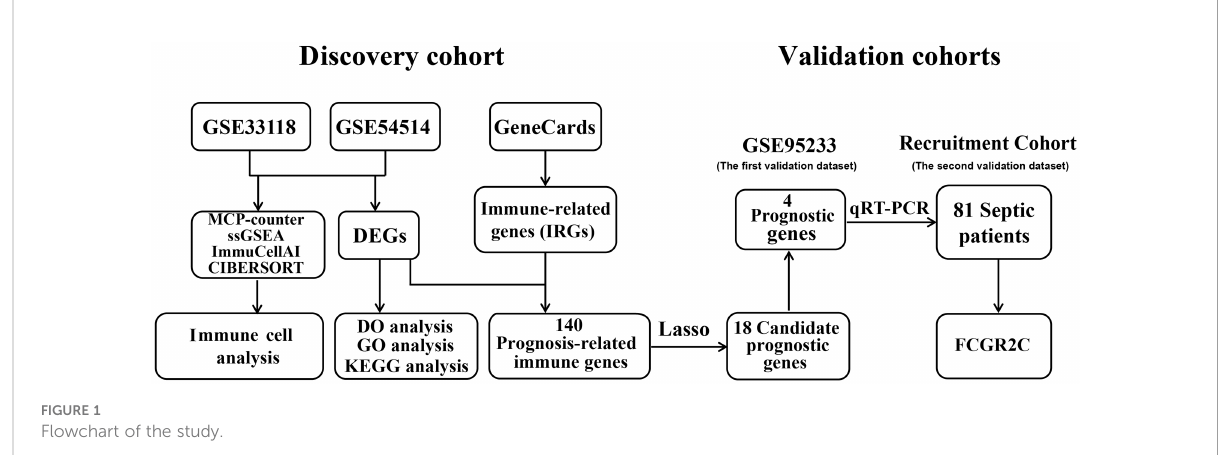
FIGURE 1 Flowchart of the